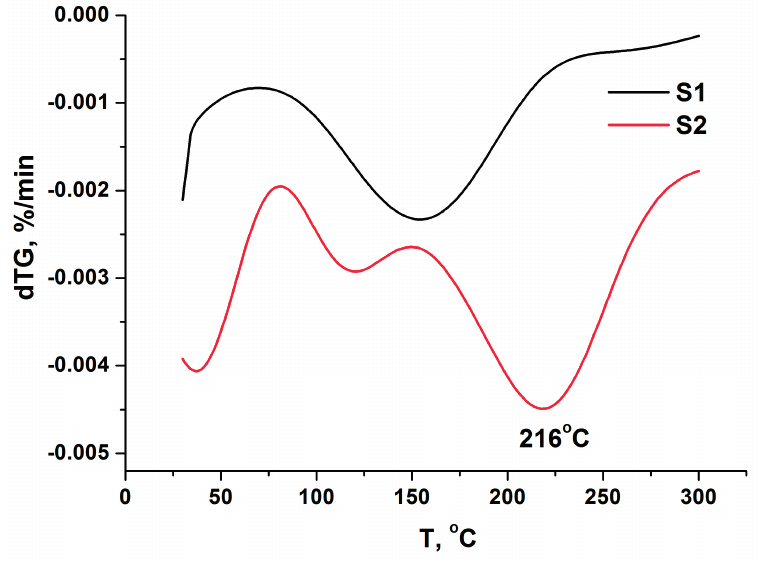
Figure 1. Derivative of thermogravimetric curves for samples S1 and S2.